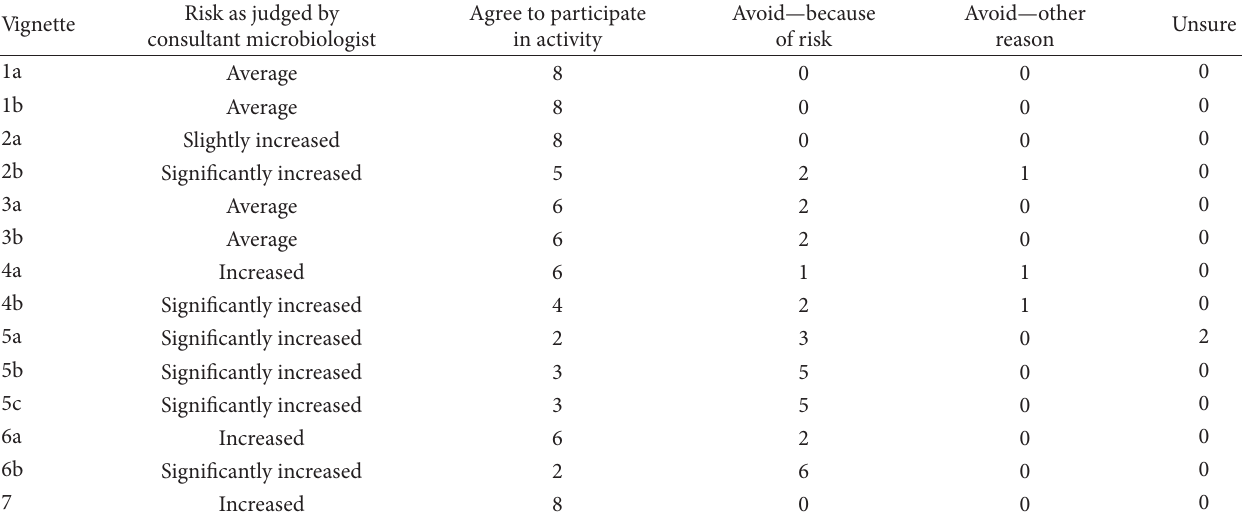
T 3: Participant responses to